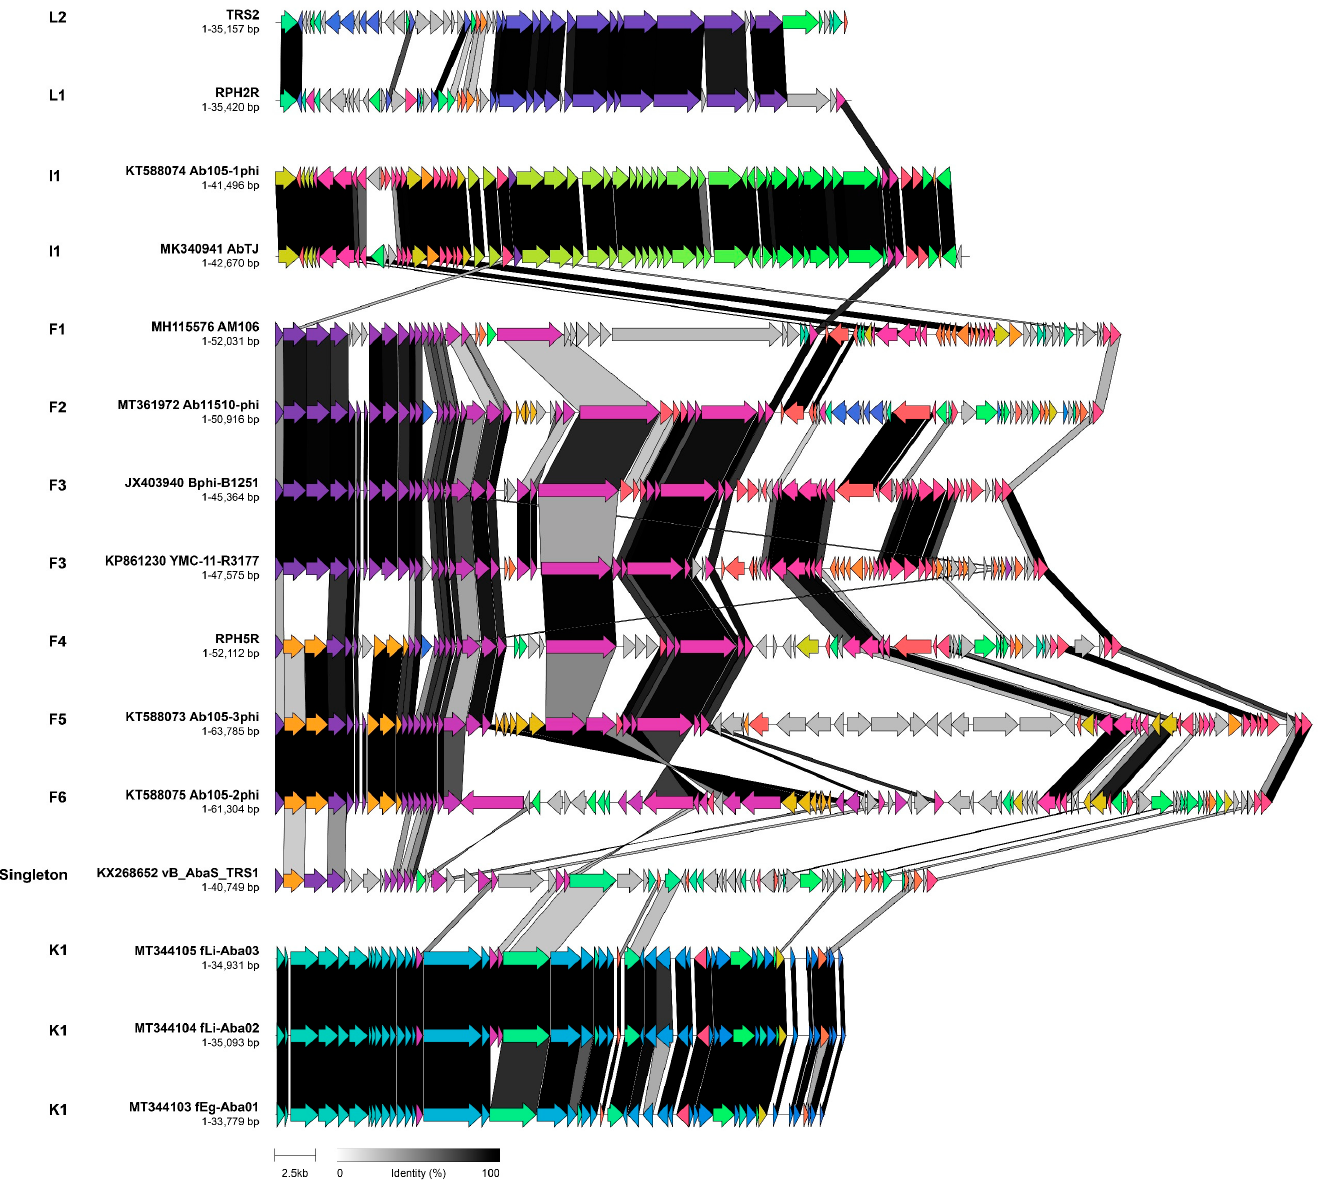
Figure 8. Comparative genome alignment of sub-clusters comprising of temperate phages infecting Acinetobacter sp. Phage genomes are presented alongside their designated sub-cluster, accession number, name and genome length. Coding sequences are represented by arrows, coloured to reflect homologous groups identified by Clinker, and are linked by grey bars shaded to represent the percentage amino acid identity, as indicated in the legend.